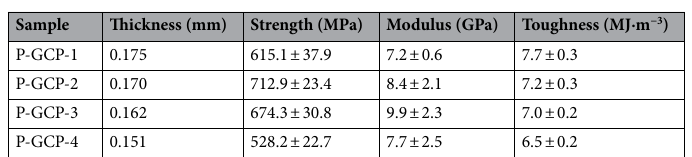
Table 3. Thicknesses and mechanical properties of P-GCP ternary artificial nacre.